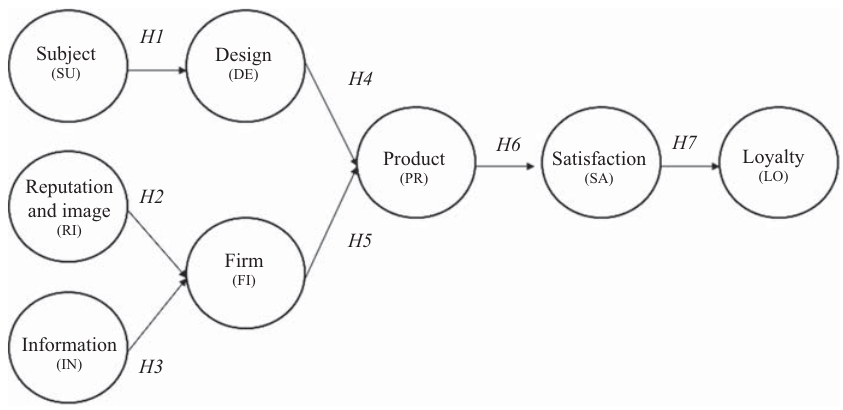
Figure 1. Causal